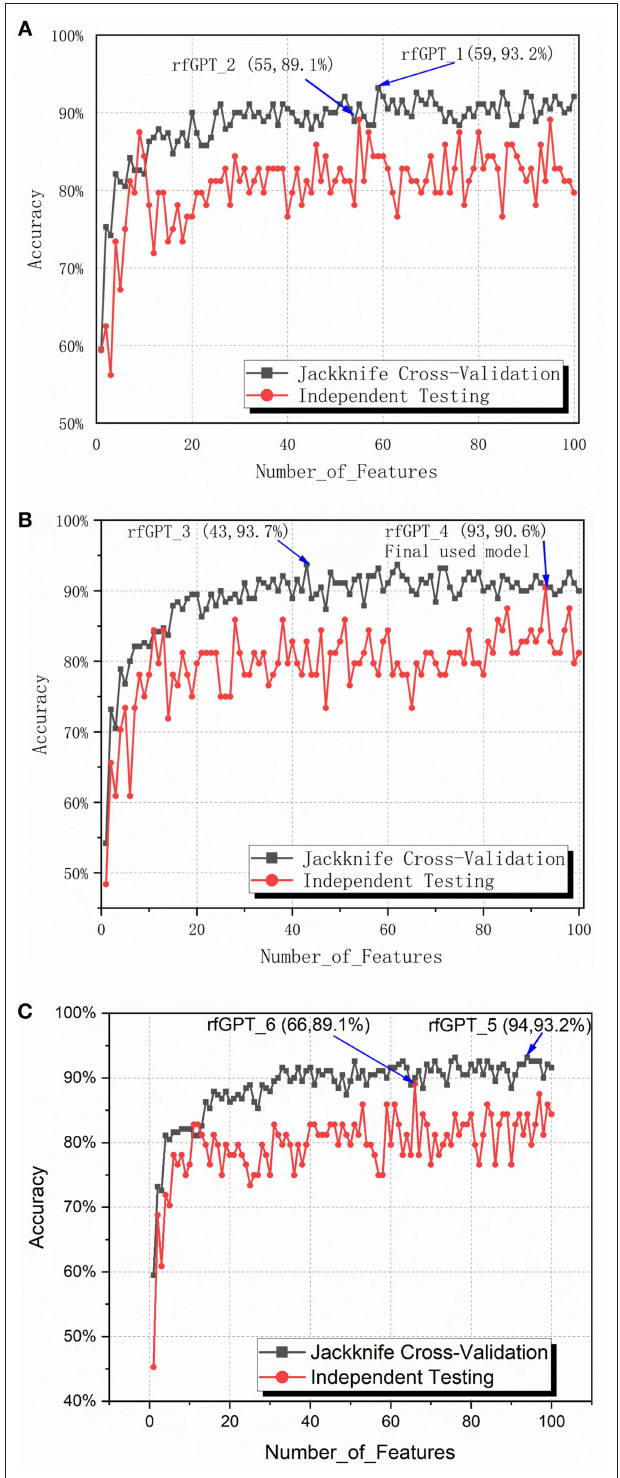
FIGURE 2 | Jackknife cross-validation and independent testing accuracy of the random forest classifier with the number of features varied: (A) 2-gap dipeptide composition (2-gapDC) features (B) 59 selected 2-gapDC features 60 split amino acid composition (SAAC) features, and (C) 55 selected + 2-gapDC features 60 SAAC +